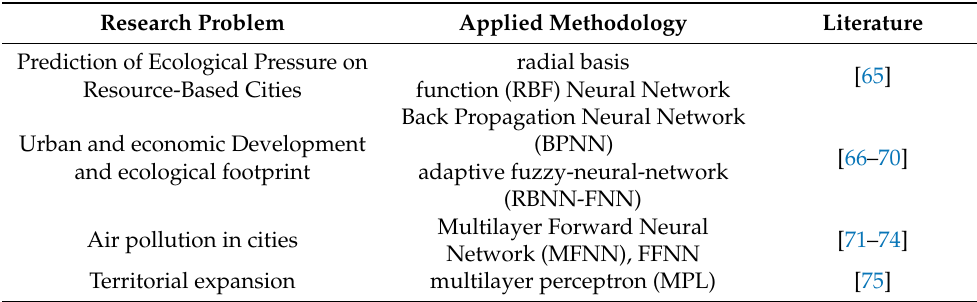
Table 1. The summary table of literature